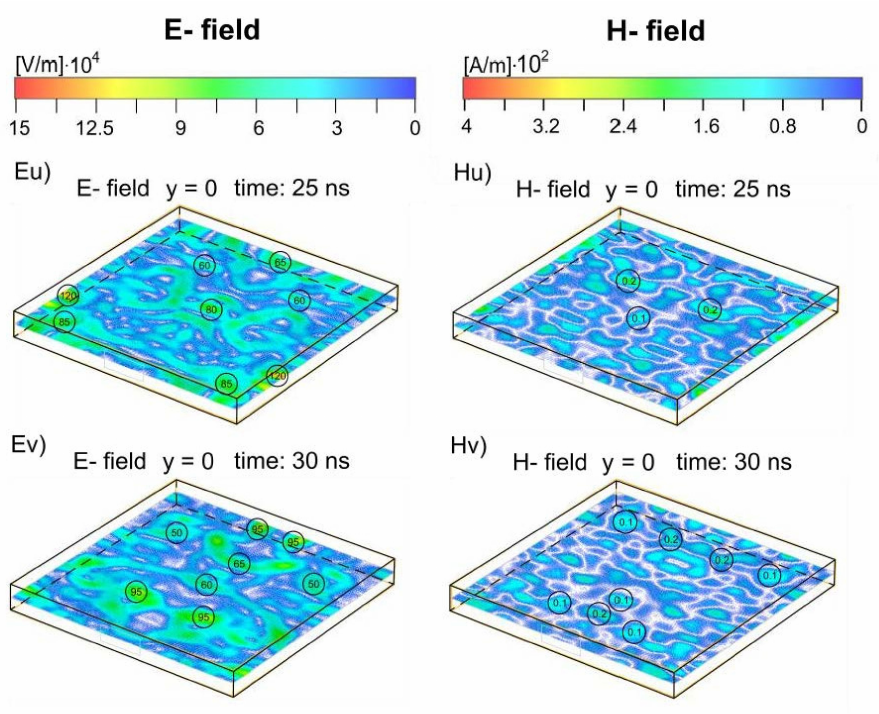
Figure 6. 2D development of the electric and magnetic fields in the enclosure. ( Ea – Ev )—the elec- tric field amplitude; ( Ha – Hv )—the magnetic field amplitude. The amplitudes of the electric field (in 10 3 V/m) and the magnetic field (in 10 3 A/m) are given in circles.